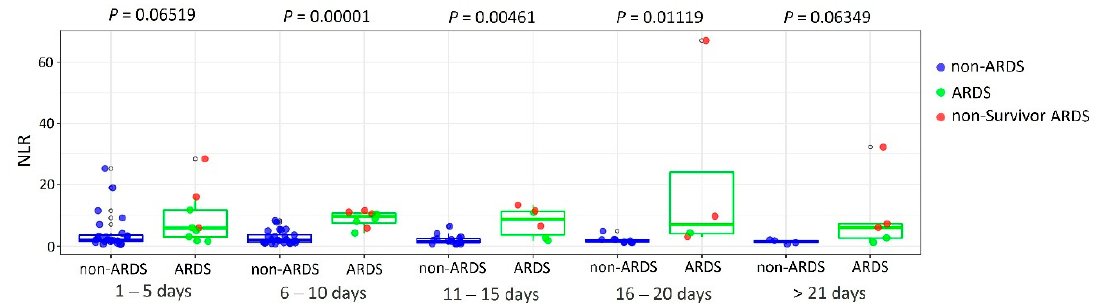
Figure 1. Comparison of NLR between ARDS and non-ARDS COVID-19 patients.